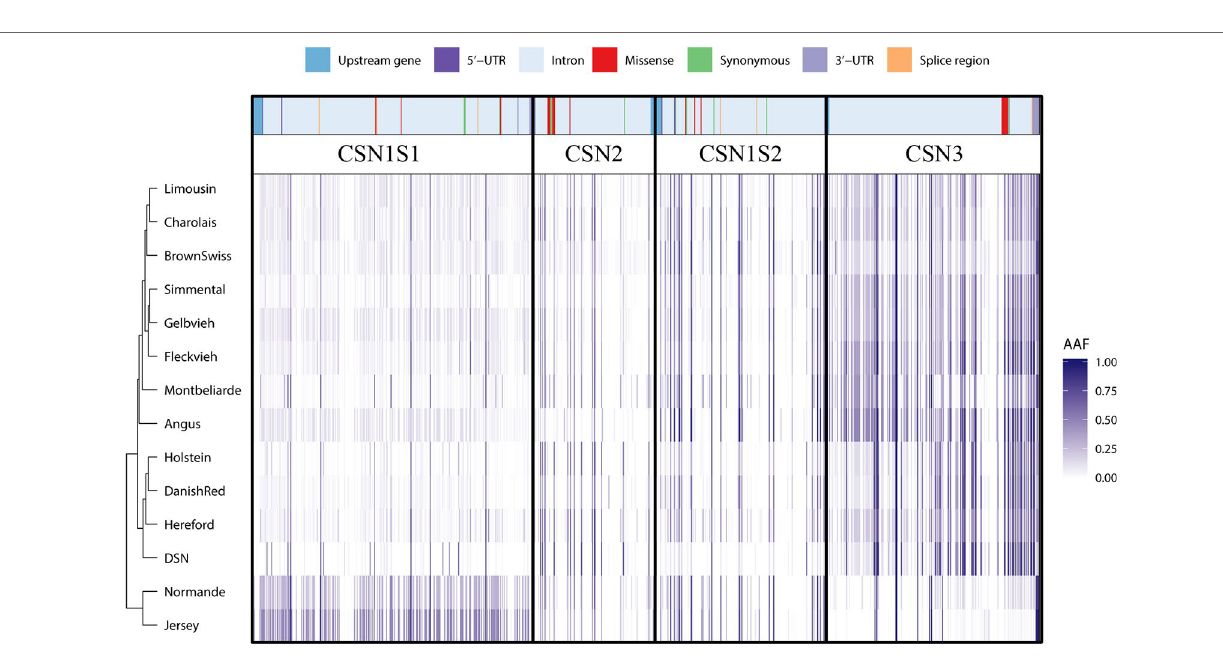
FIGURe 2 | Clustering of per-breed alternative allele frequency for the detected sequence variants in the casein genes CSN1S1 , CSN2 , CSN1S2 , and CSN3 including their 1,000-bp upstream region. The respective variant types are presented above the alternative allele frequencies. It should be noted that the clustering is mainly based on intron variants ( light blue areas ) as they make up 87.3% of all detected